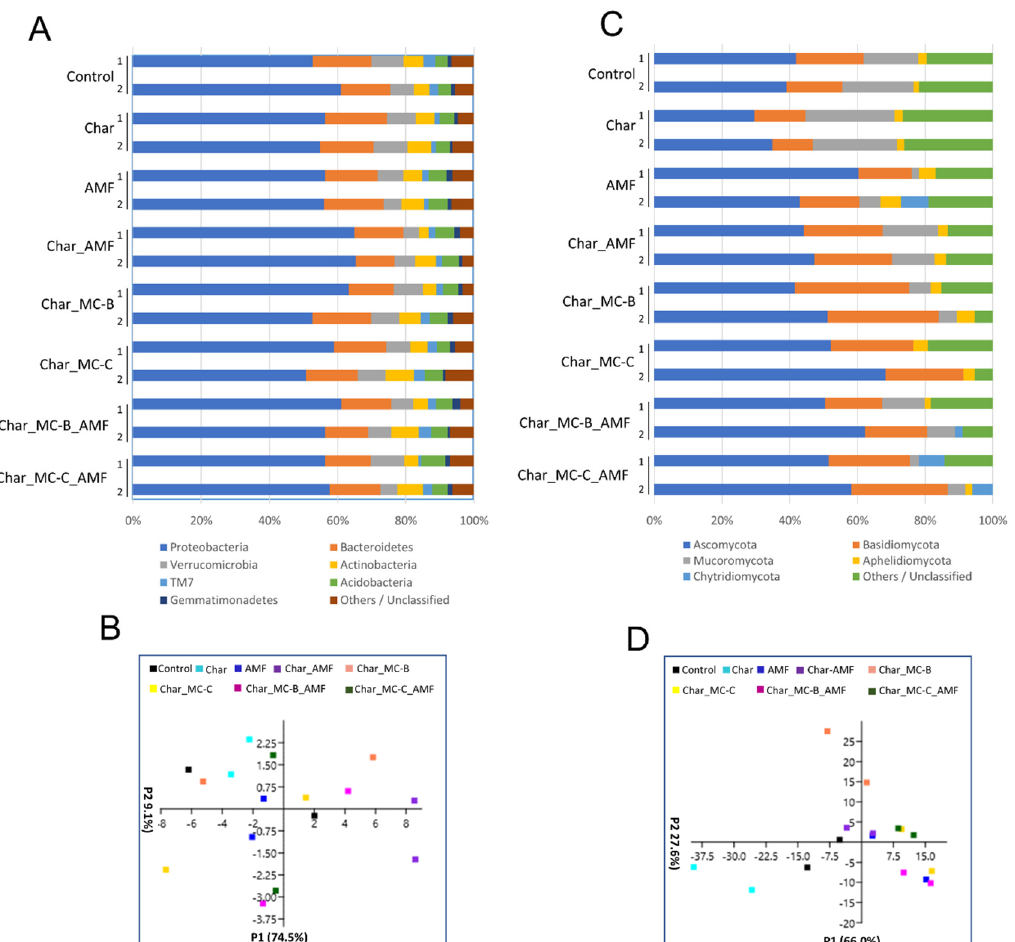
Figure 3. Phyla of rhizospheric bacterial and fungal communities in maize soils untreated or treated with different combinations of biofertilizers. ( A ) Relative abundance (based on OTUs) of the most relevant bacterial phyla found in eight rhizospheric soils of maize analyzed in duplicate (1–2); the colors are ordered from left to right according to the legend reported at the bottom of the panel; ( B ) PCA analysis of the eight selected bacterial communities in the different maize soils analyzed. ( C ) Relative abundance (based on OTUs) of the most relevant fungal phyla found in eight rhizospheric soil of maize analyzed in duplicate (1–2); the colors are ordered from left to right according to the legend reported at the bottom of the panel ( D ). PCA analysis of eight fungal communities in the different maize samples analyzed. Each symbol (squares) represents one replicate and the colors follow the legend reported at the top of the panel.